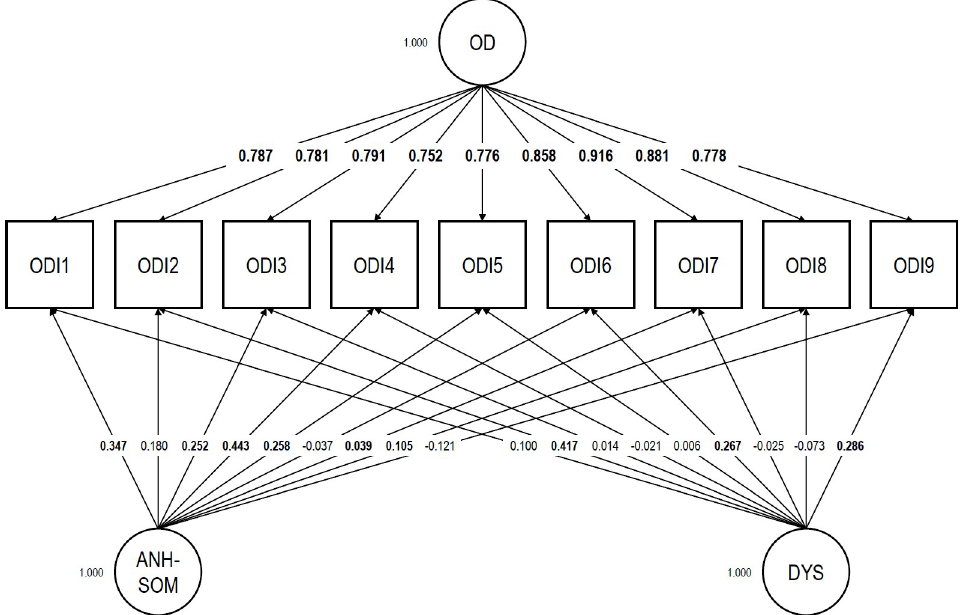
Fig 1. Exploratory structural equation modeling bifactor analytic model of the Occupational Depression Inventory ― factor loadings. Target loadings are bolded. RMSEA = 0.019; CFI = 1.000; TLI = 0.999; SRMR = 0.010; χ 2 (12) = 13.397. OD: general Occupational Depression factor; ANH-SOM: Anhedonic-Somatic bifactor; DYS: Dysphoric